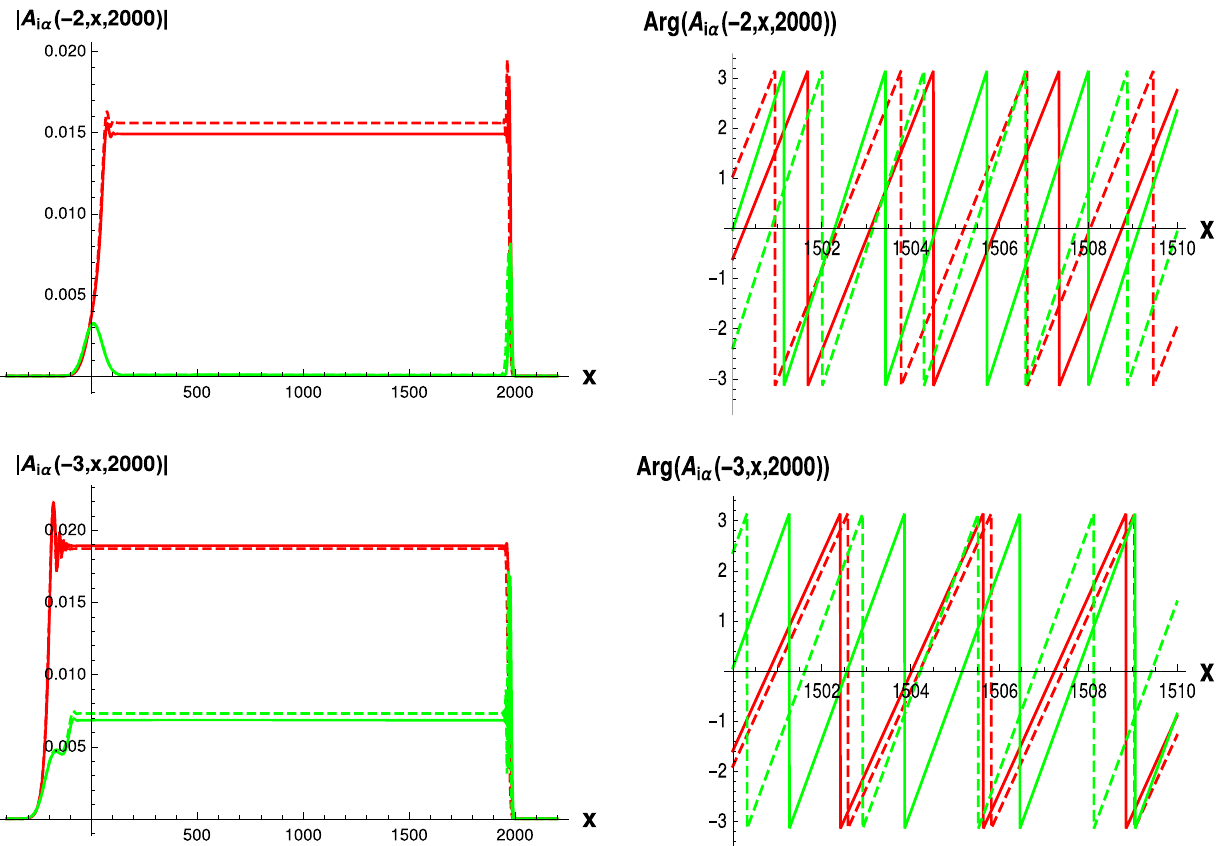
Fig. 8 As in Fig. 6 but at t = 2000 and for a smaller mass splitting m 1 = 0 . 30 and m 2 = 0 . 35 and worse momentum resolution σ = 0 .